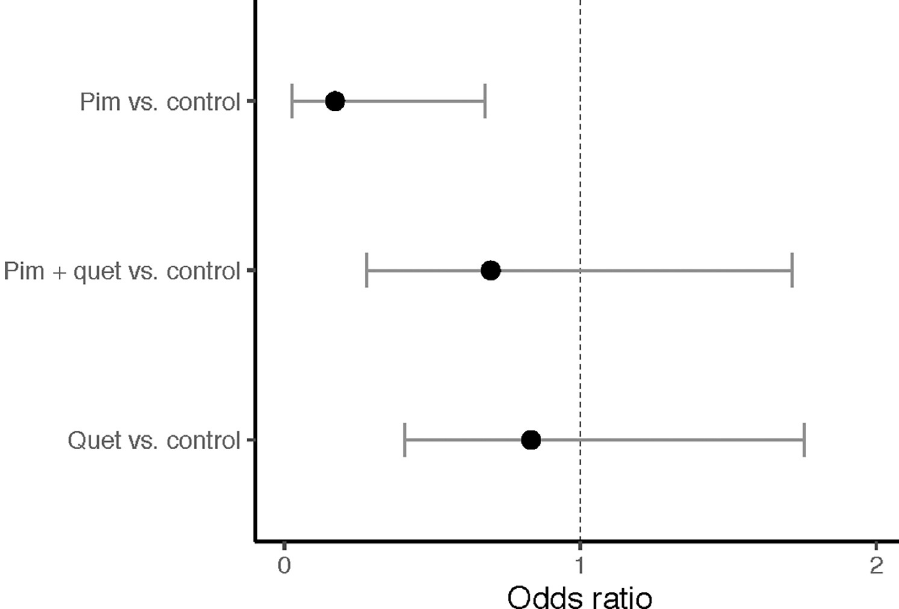
Fig 1. Mortality odds ratio in untreated and treated groups with Parkinson disease psychosis. Comparison of mortality odds ratios between Parkinson disease psychosis (PDP) patients not receiving antipsychotics (untreated) and PDP patients treated with either pimavanserin (Pim), quetiapine (Quet), or combination pimavanserin and quetiapine (Pim+Quet), after adjusting for age, sex, last visit levodopa equivalent daily dose, and